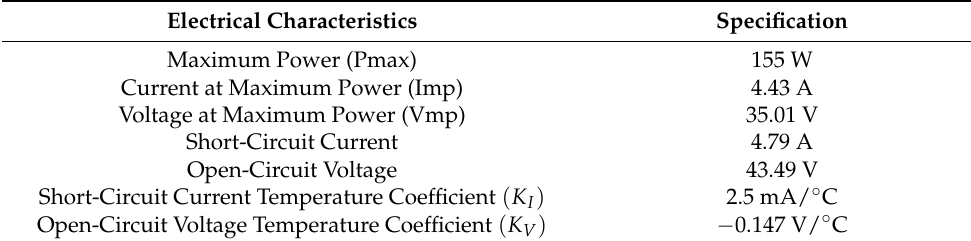
Table 2. The PV module parameters (TYN-155S5) ( @1 kW/m 2 , 25 ◦ C )